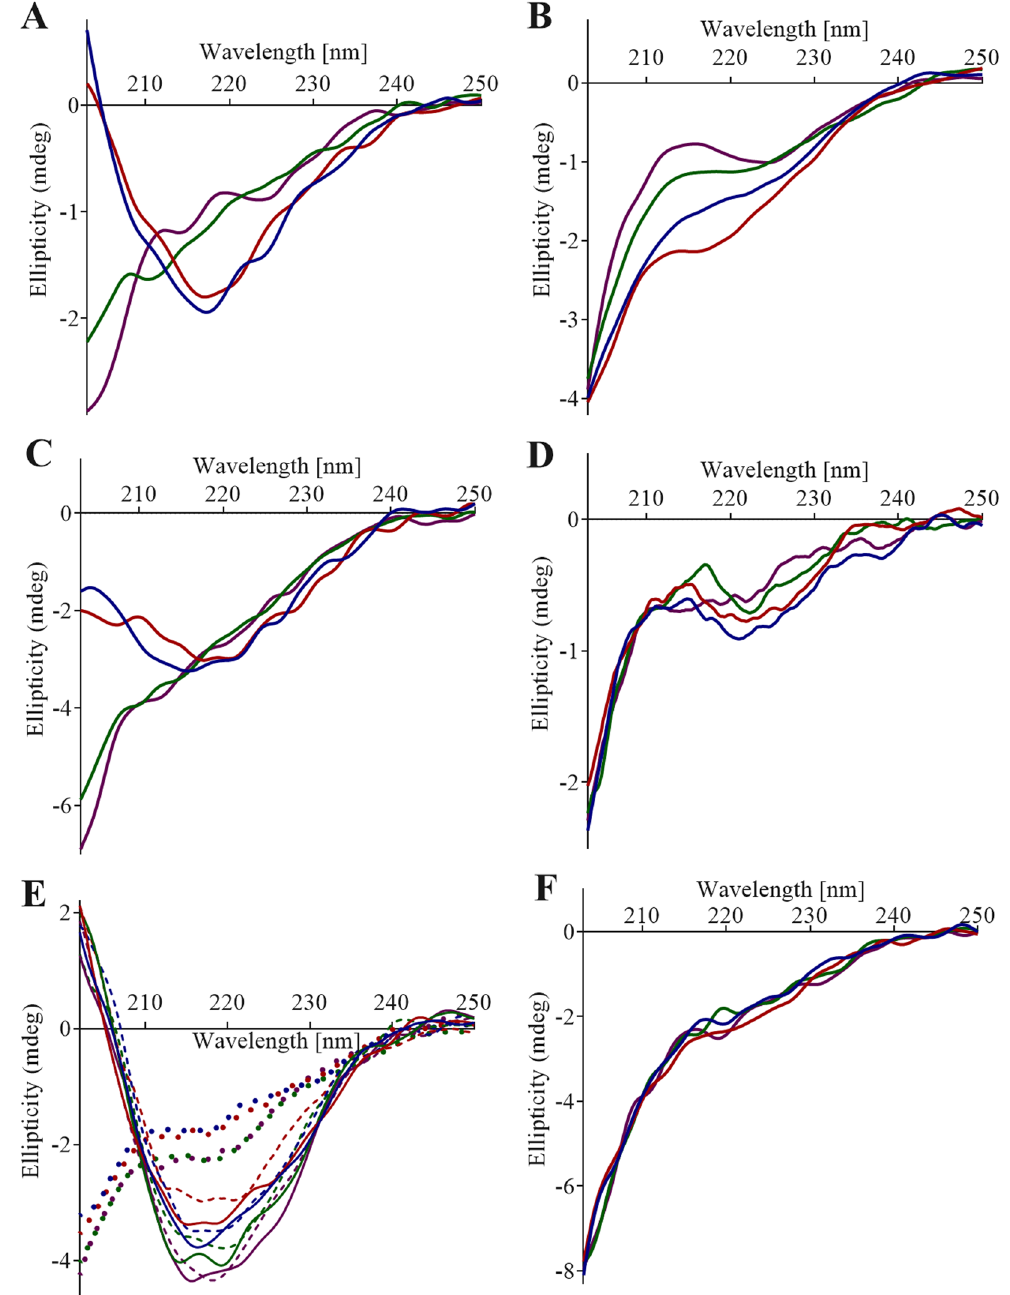
Figure 12. Far-UV CD spectra of peptides in buffered saline (140 mM NaCl) containing 10 mM DTT at pH 3.0 (blue), 4.5 (red), 6.2 (green), and 7.4 (purple); ( A ) H1; ( B ) H2; ( C ) H1H2; ( D ) X; ( E ) H3 (solid lines), H3 incubated with 1:1:1 POPC:POPE:POPS LUVs (100 µ M phospholipid; broken lines), K83Q H3 (circles); and ( F ) H4. The buffers used were 27 mM sodium phosphate pH 3.0, 50 mM sodium acetate pH 4.5, 20 mM sodium phosphate pH 6.2, and 10 mM sodium phosphate pH